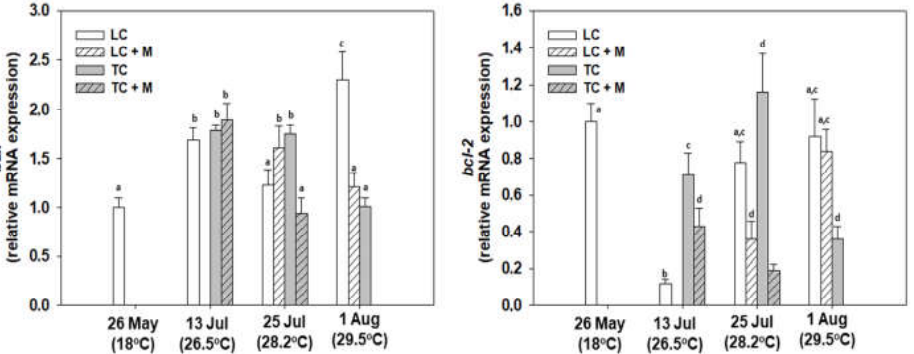
Figure 8. Relative bax and bcl-2 mRNA expression levels in the mantle of M. galloprovincialis specimens, either infected by Martelia spp. (M) or not. Samples were collected from Thermaikos gulf during a summer heatwave both from traditional culture-Bouchot (TC) and long-line system (LC). Values represent means ± SD; n = 5 preparations from different animals. Lower case letters indicate statistically significant differences ( p < 0.05) between samples.